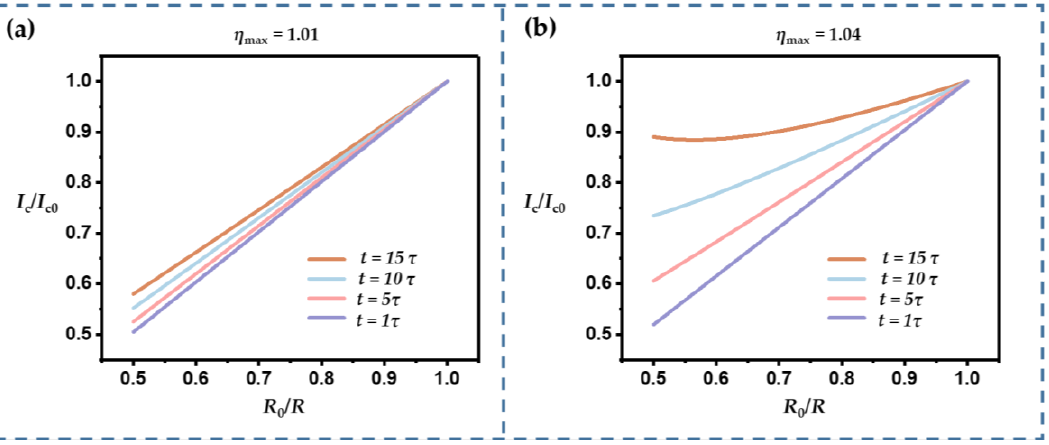
Figure 4. I c / I c 0 vs. R 0 / R for different moments at which RC started to change: ( a ) η max = 1.01, ( b ) η max = 1.04.